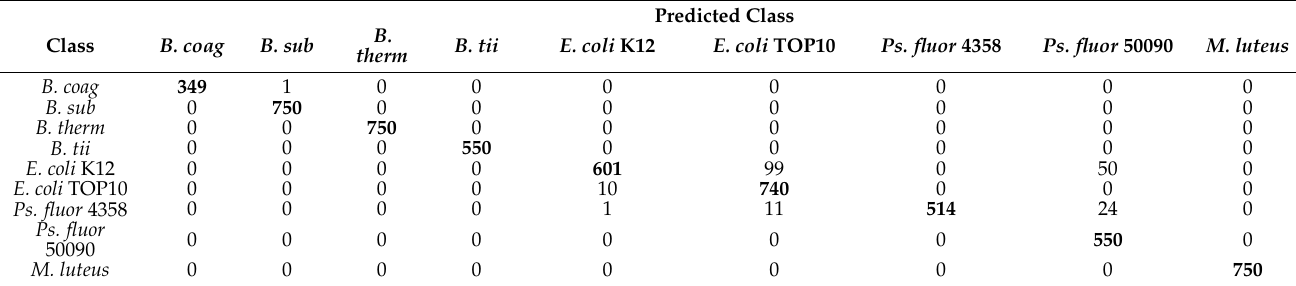
Table 2. Confusion matrix for the independent test data set. All nine conditions were pooled as one class per microorganism. The rows show the observed groups and the columns show the predicted groups. The values in the diagonal of the table reflect the correct classifications of observations into groups.